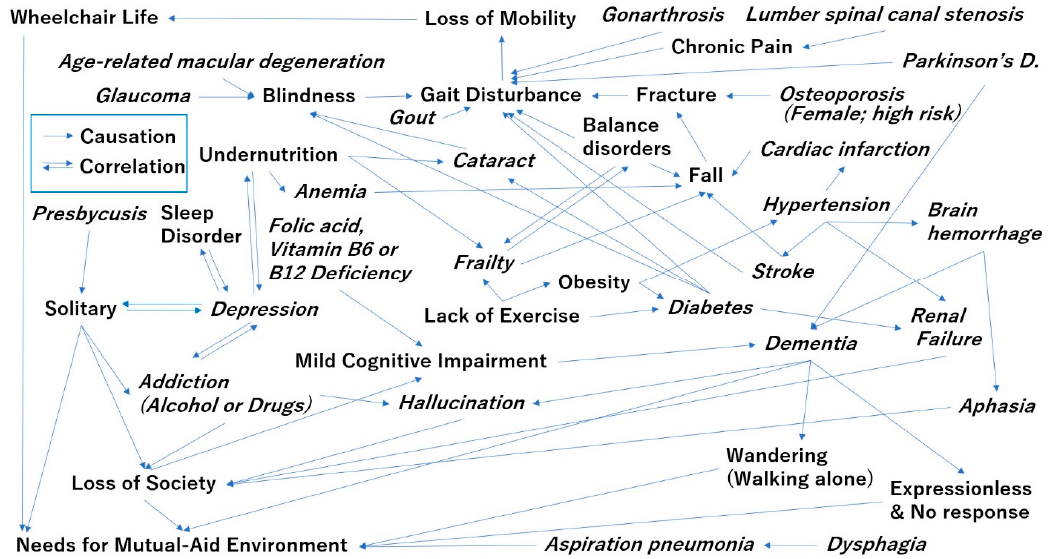
Figure 11. Relationships between gerontology and geriatrics without cancers .